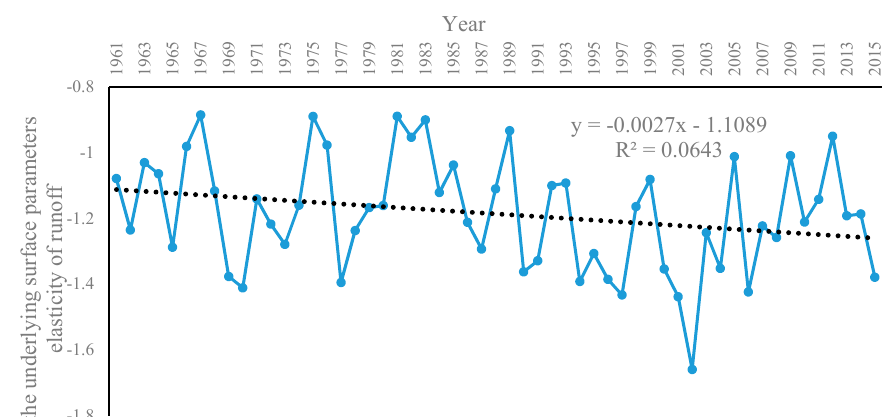
Figure 7. Changing trend of the potential evaporation elasticity of runoff.